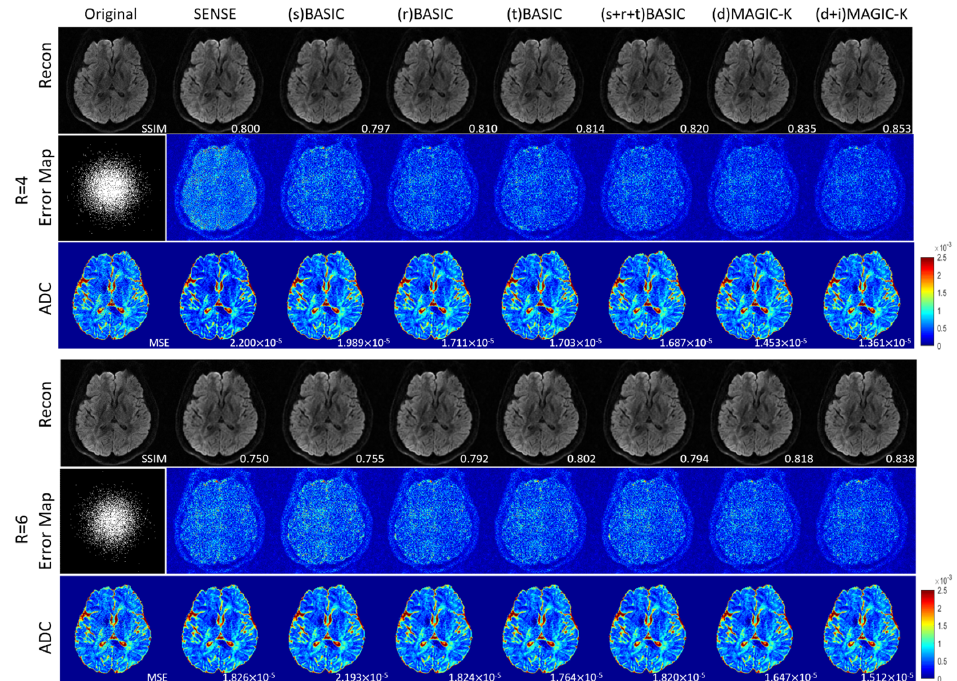
Figure 4. Comparison of the reconstructed images by different image augmentation strategies, using variable density undersampling in a healthy volunteer. The SSIM is listed at the bottom-right of each reconstructed image. The error map was ×10 amplified for better visualization. The MSE is listed at the bottom-right of each ADC map.